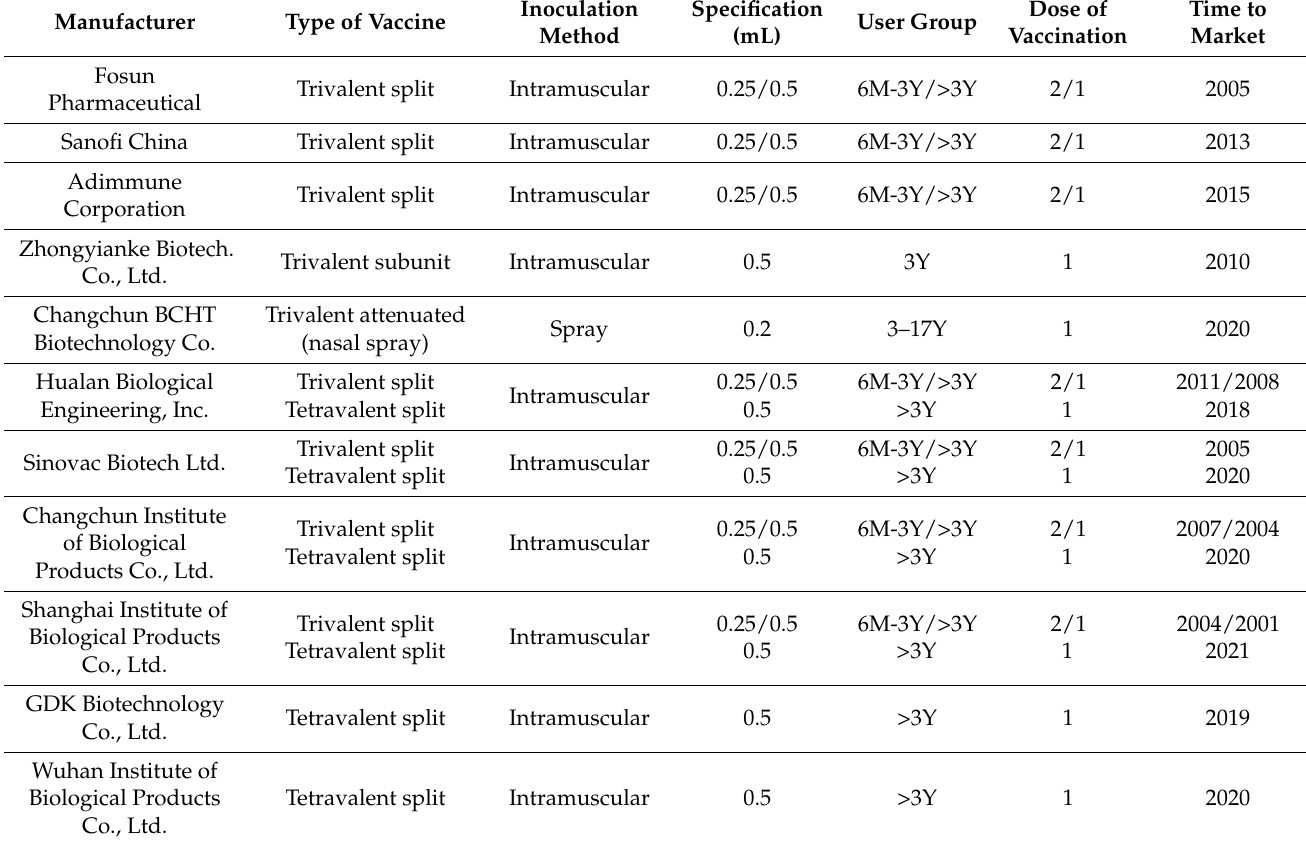
Table 1. The list of influenza vaccine issuance manufacturers for the year